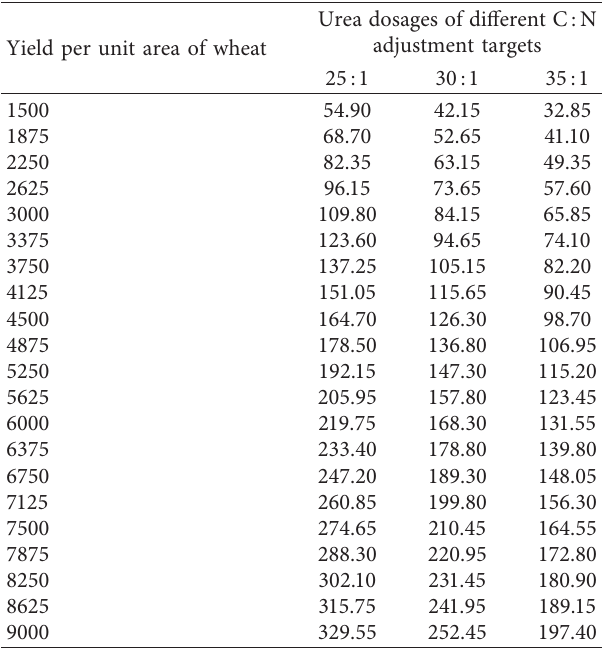
Table 3: C :N of straw of some grain and cash crops. Table 4: Enquiry table for the urea application rate of wheat straw returning to the field with different yields per unit